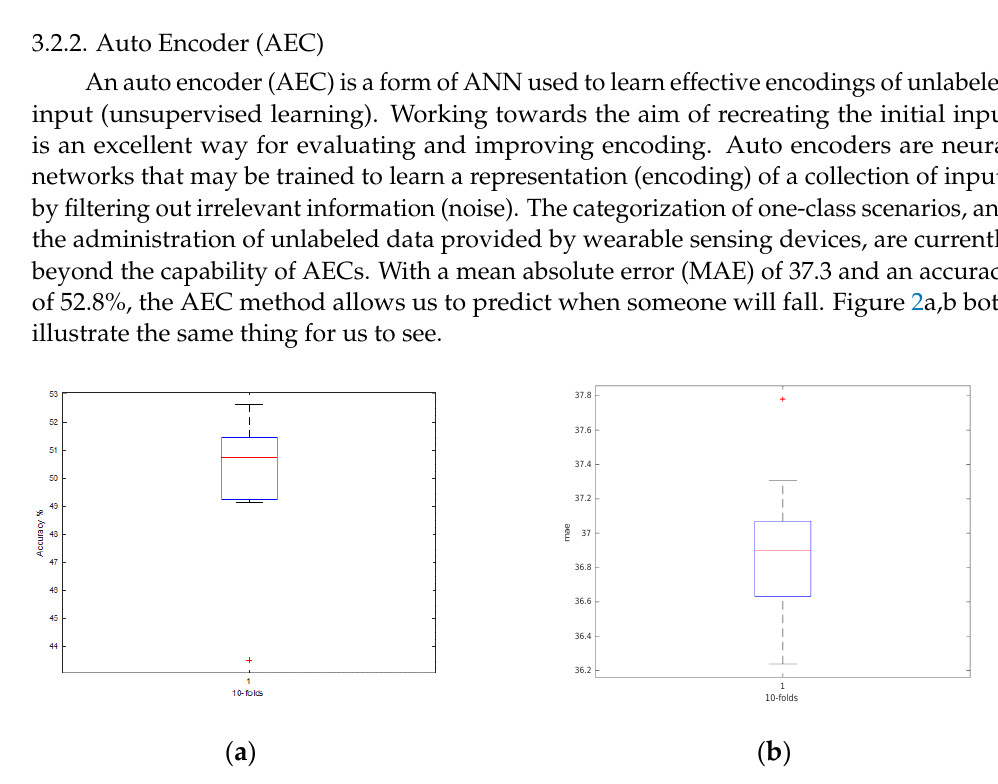
Table 1. The distribution of activity data.